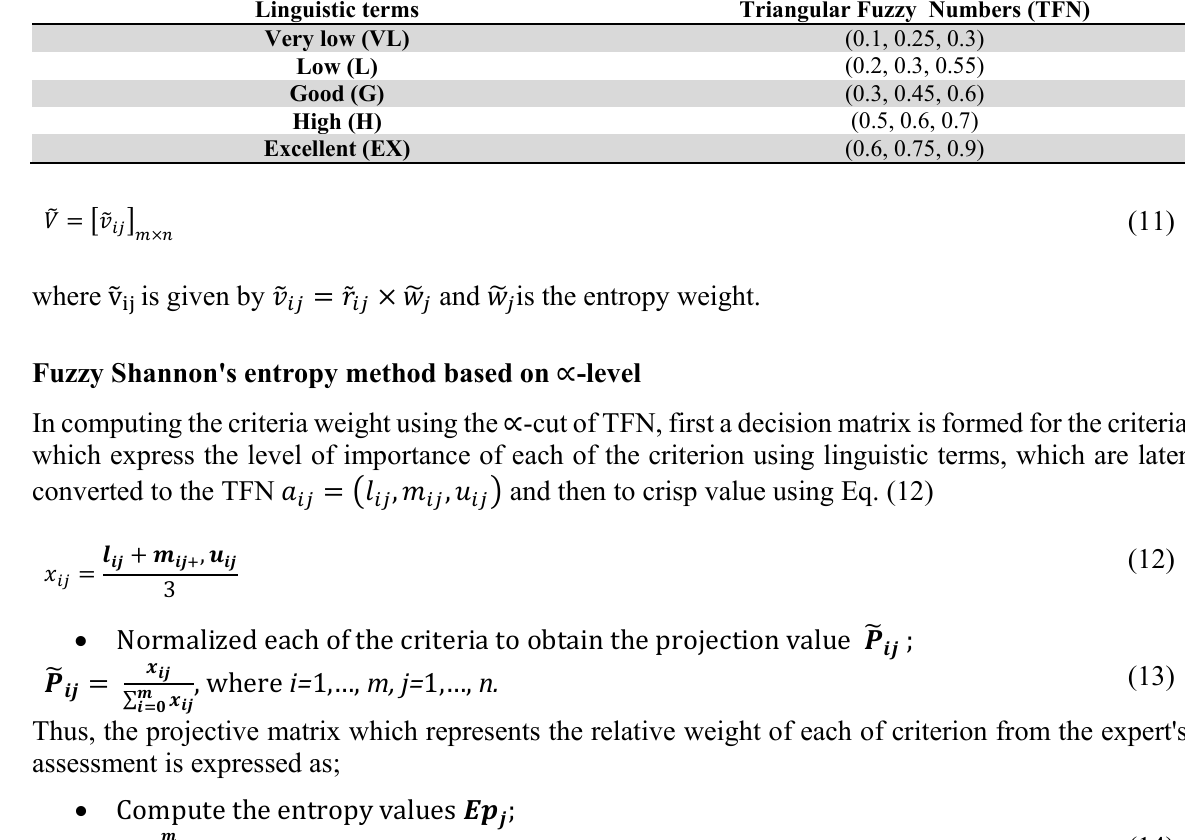
Table 2 Fuzzy numbers for approximating the linguistic variable Linguistic terms